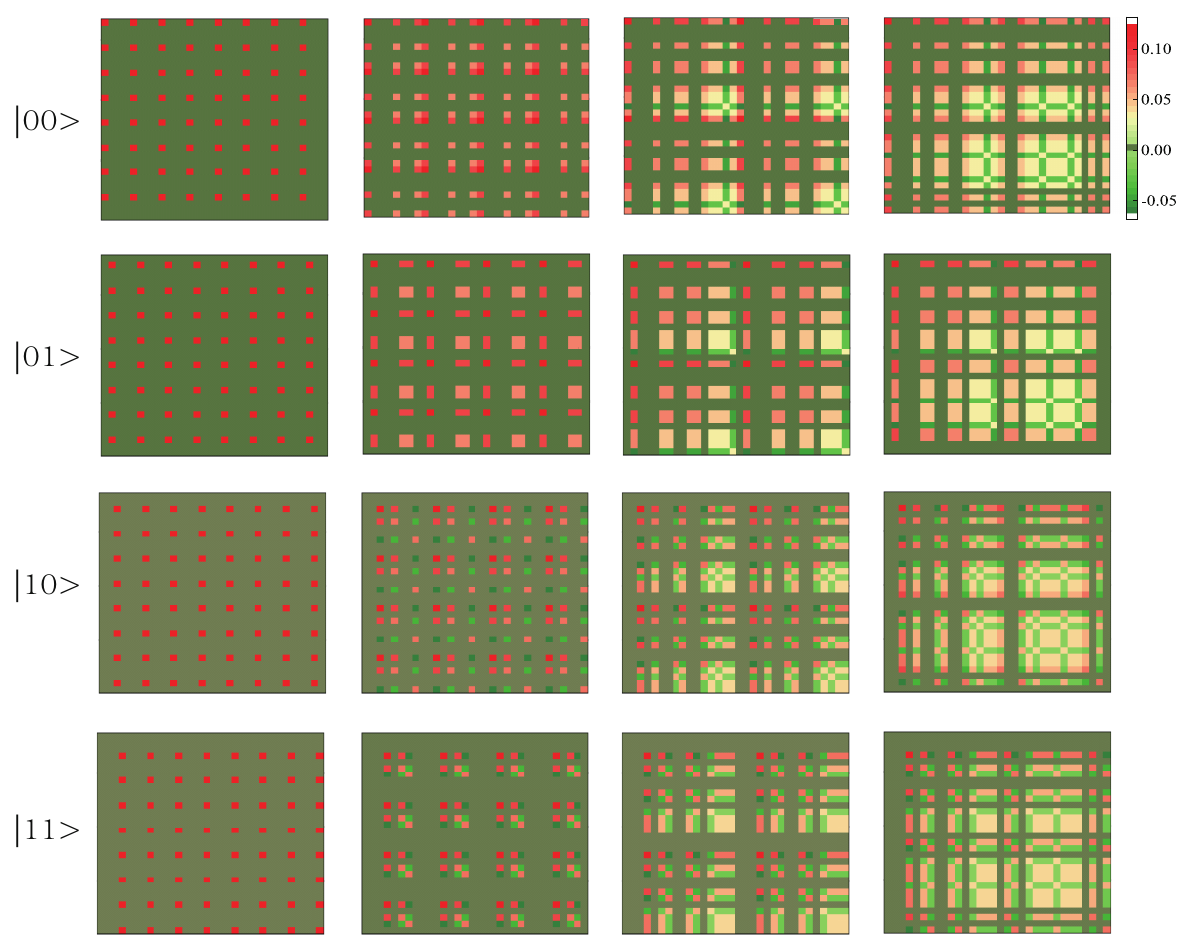
(cid:78) 3 | 00 (cid:105) , 1 , ρ 2 , ρ 3 , and ρ 4 ,